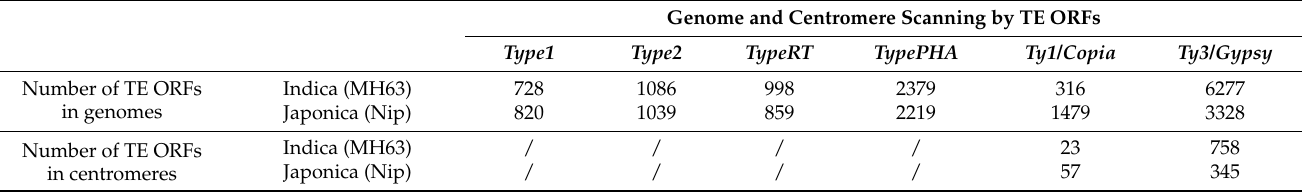
Figure 2. The phylogenetic analysis of the Nip and MH63 TE super-family clusters and ORF reference sequence identifications for each cluster. ( A ) Phylogenetic trees of type1 TE ORFs for Nip and MH63, the ref-N-type1 and ref-M-type1 sequence on the top branch was selected as the reference sequences for the N-type1 and M-type1 clusters, respectively. ( B – F ) In the same format as ( A ), for type2 , typeRT , typePHA, Ty1 / Copia and Ty3 / Gypsy , respectively. The TE ORF reference sequences on the top of the branch for each cluster are shown in red. Table 2. The whole genome and centromere scanning with six TE ORF reference sequences in MH63 and